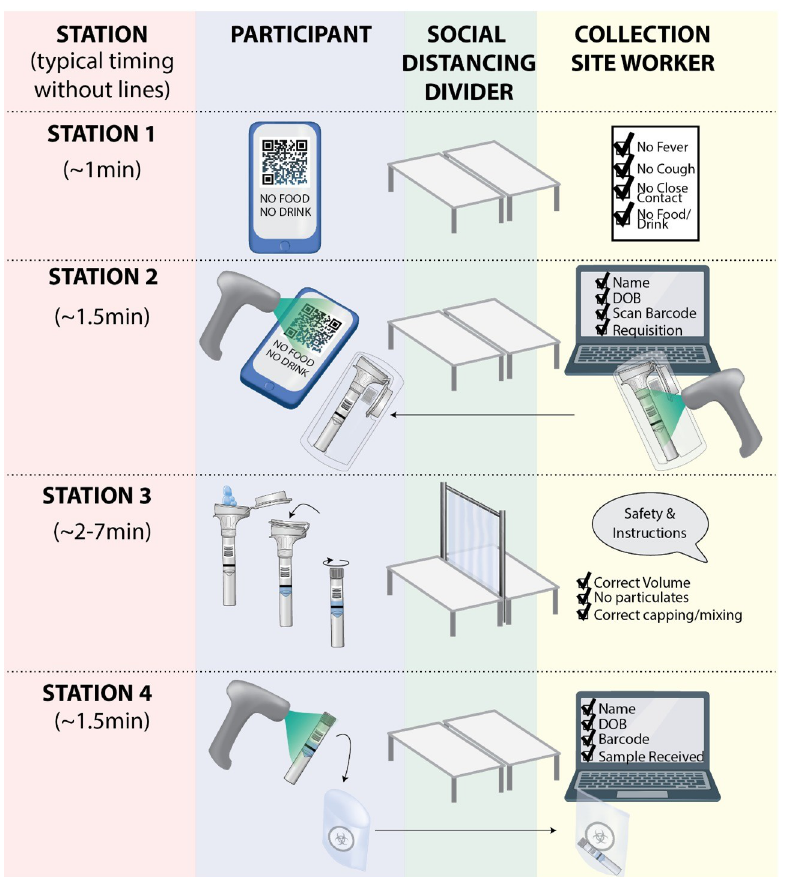
Fig 2. IGI FAST testing site workflow. Our two testing sites followed the same workflow, which can be easily scaled to increase the throughput. Participants first checked in at station one, where they were screened for COVID-19 symptoms, potential contacts, and recent food or water consumption. At station 2, an appointment QR code was scanned, and a collection site worker created a test requisition. Participants then went to individually-staffed spitting stations, where they were supervised while giving their sample. At station 4, the tube was re-scanned, and participants confirmed their name and date of birth. At this point, the sample was dropped into a bag and left with the site worker. Parts of figure made using